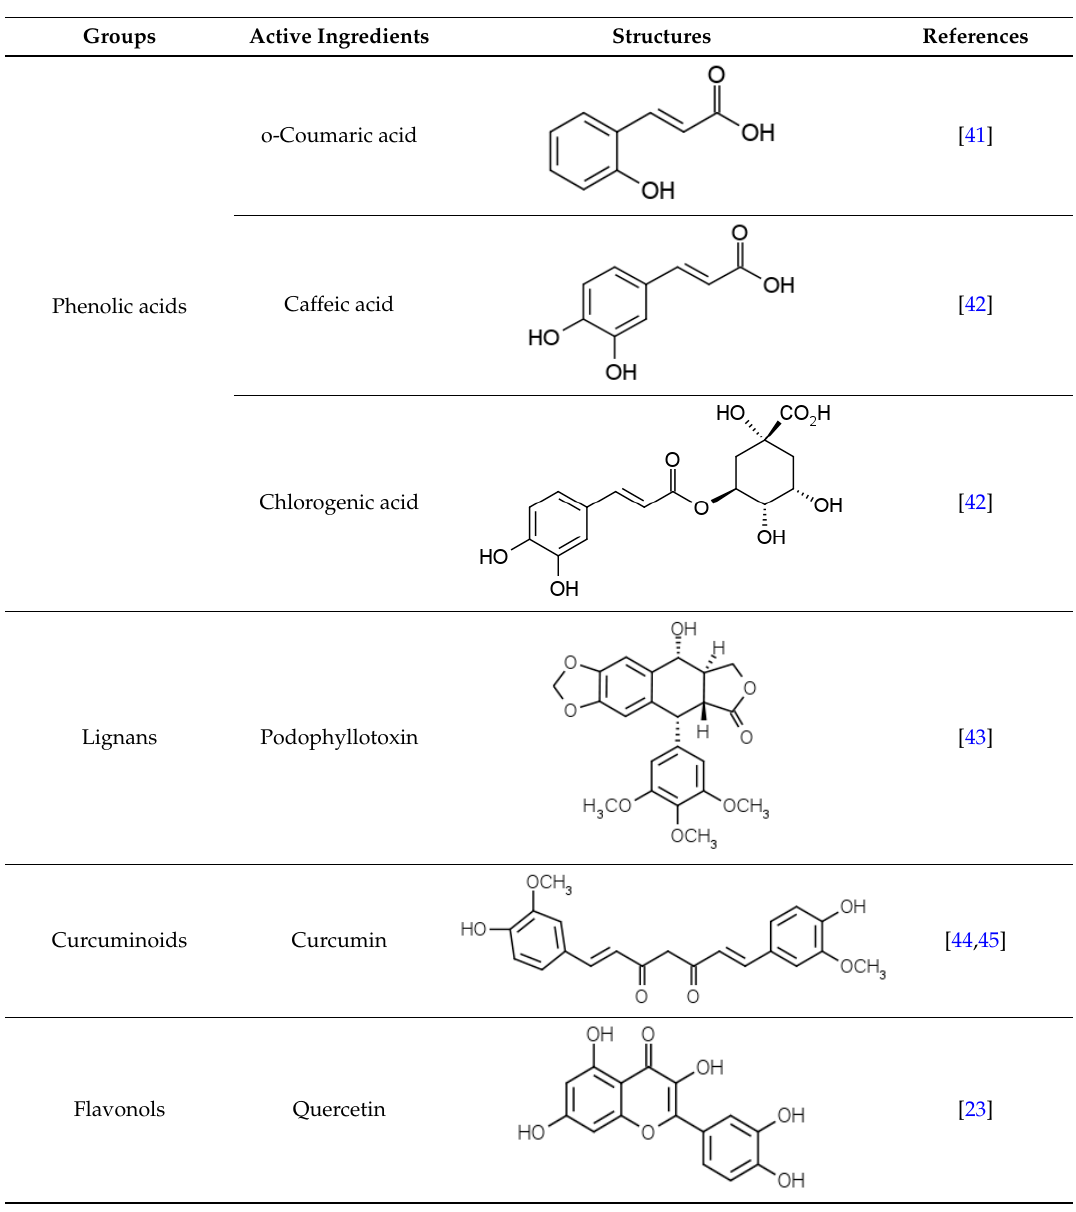
Table 2. Phytochemicals with anti-obesity effects.